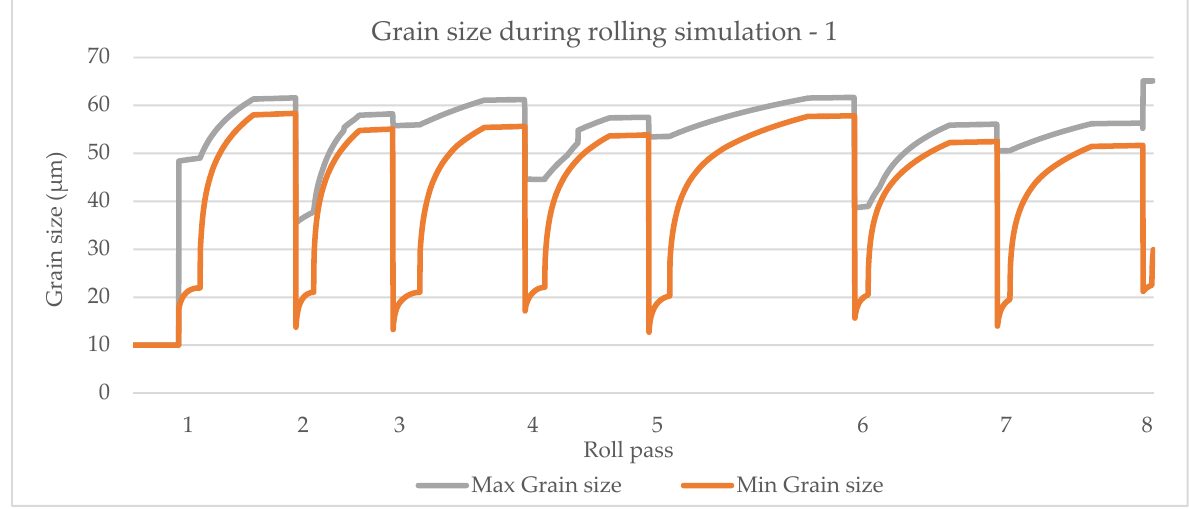
Figure 14. Simulation of maximum and minimum grain size based on the model by Sellars and Whiteman [14].